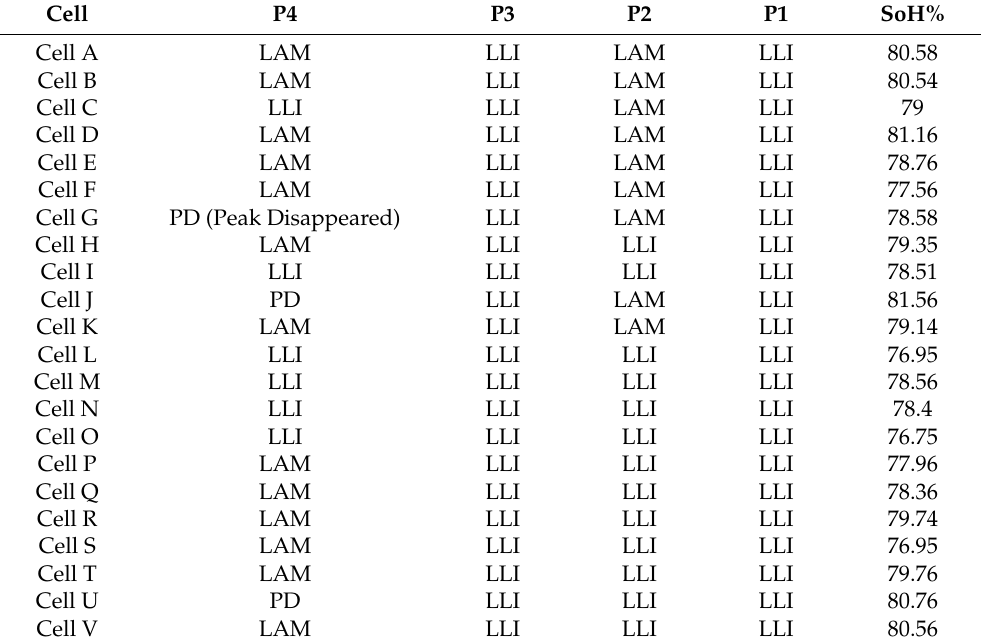
Table 5. DM of the